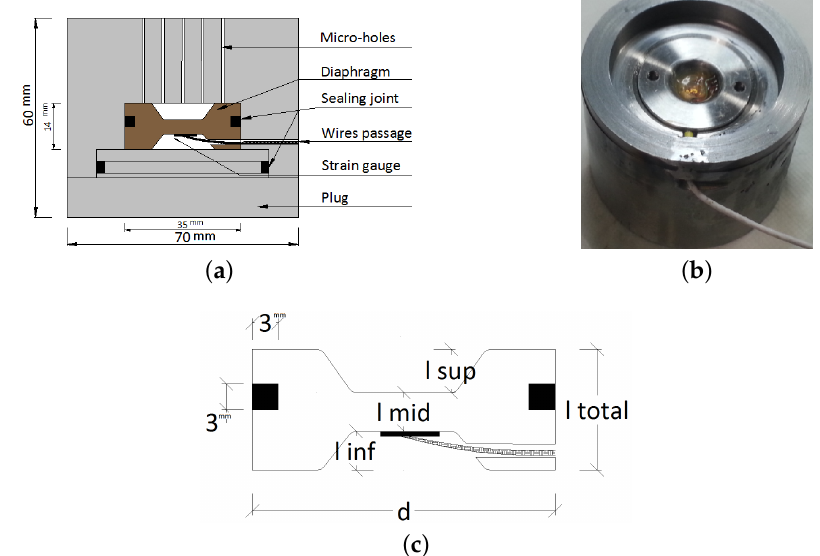
Figure 4. Steel sensor of membrane type: ( a ) cross section of the collecting cap with the membrane sensor; ( b ) picture of the cap and pressure sensor; and ( c ) proposed design of the membrane sensor with the gauge and sealing joint position.